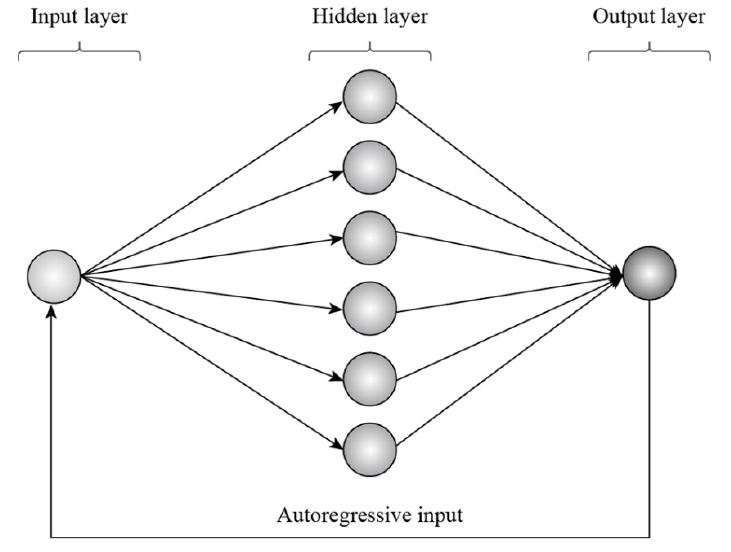
Figure 3. Conceptual illustration of a nonlinear autoregressive neural network (NAR).